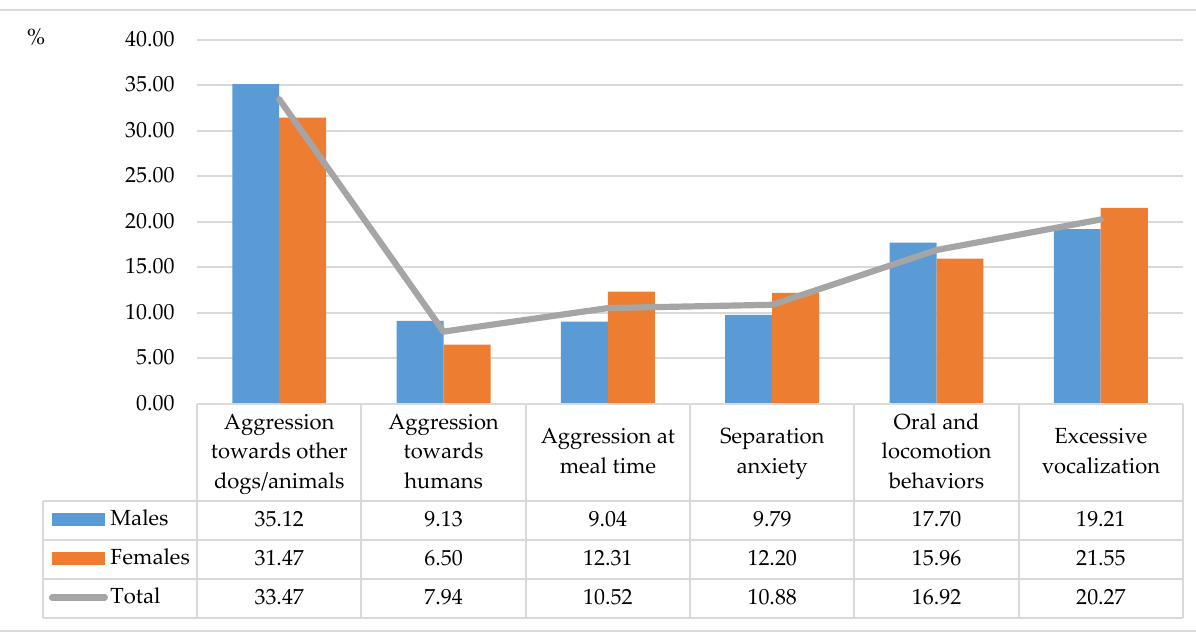
Figure 2. Incidence of undesirable behaviors in each category of behavioral problems (%).